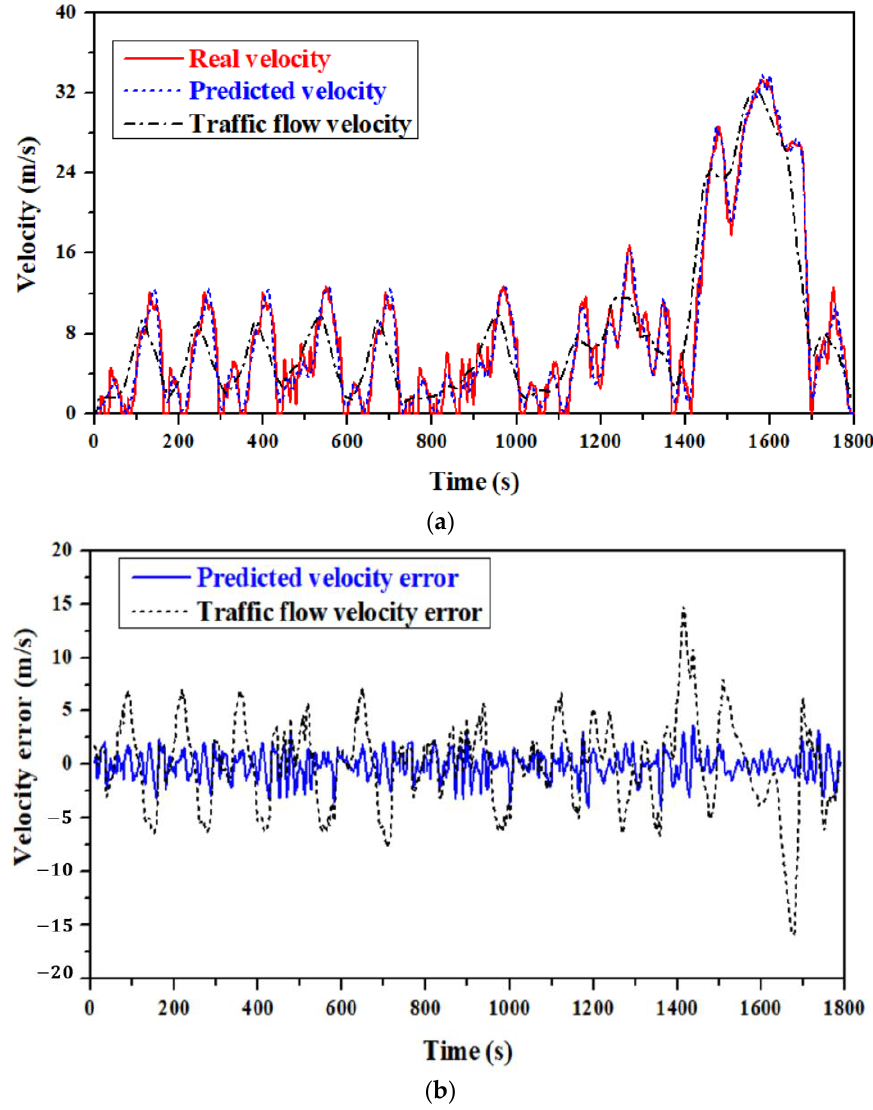
Figure 20. Comparison of the real velocity, NARX-predicted velocity and the traffic flow velocity. ( a ) Velocity comparison result; ( b ) velocity error comparison result.